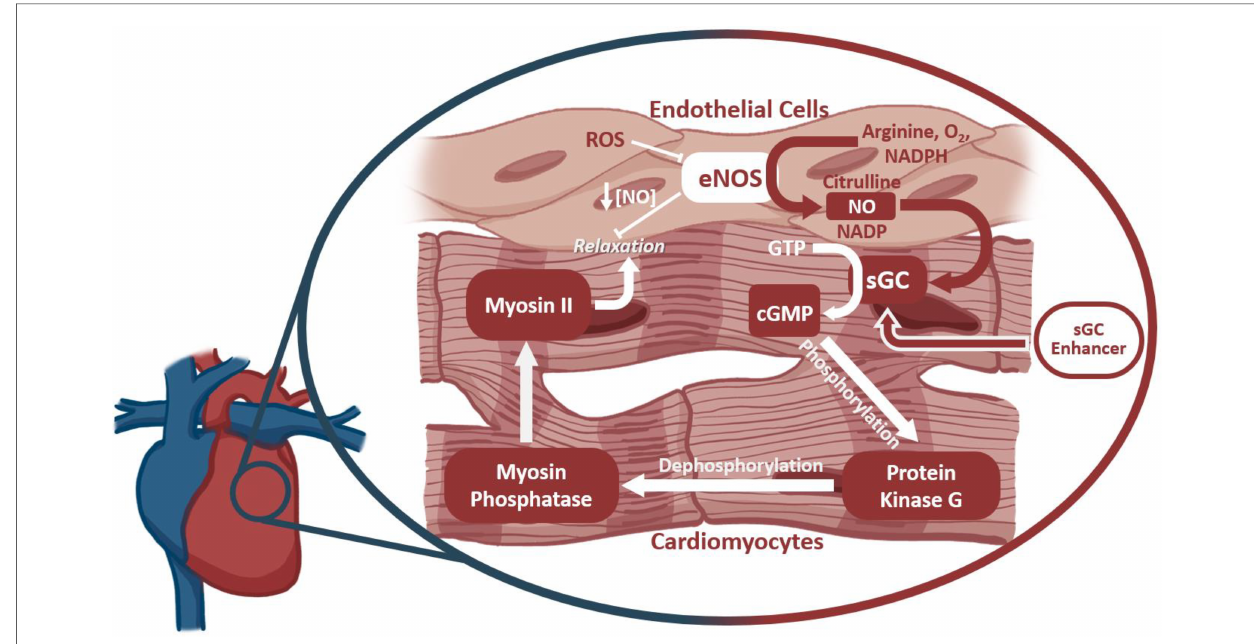
FIGURE 3 The outcome of ROS production on cardiomyocyte function. Soluble Guanylate Cyclase (sGC) drives Myosin II dephosphorylation and smooth muscle relaxation via production of the secondary messenger cGMP. sGC is activated by intercellular NO produced by endothelial nitric oxide synthase (eNOS). Reactive oxygen species inhibit eNOS activity, thereby affecting cardiomyocyte function further downstream. sGC enhancers target sGC at an allosteric site to increase its sensitivity to NO, thereby rescuing function despite lower NO